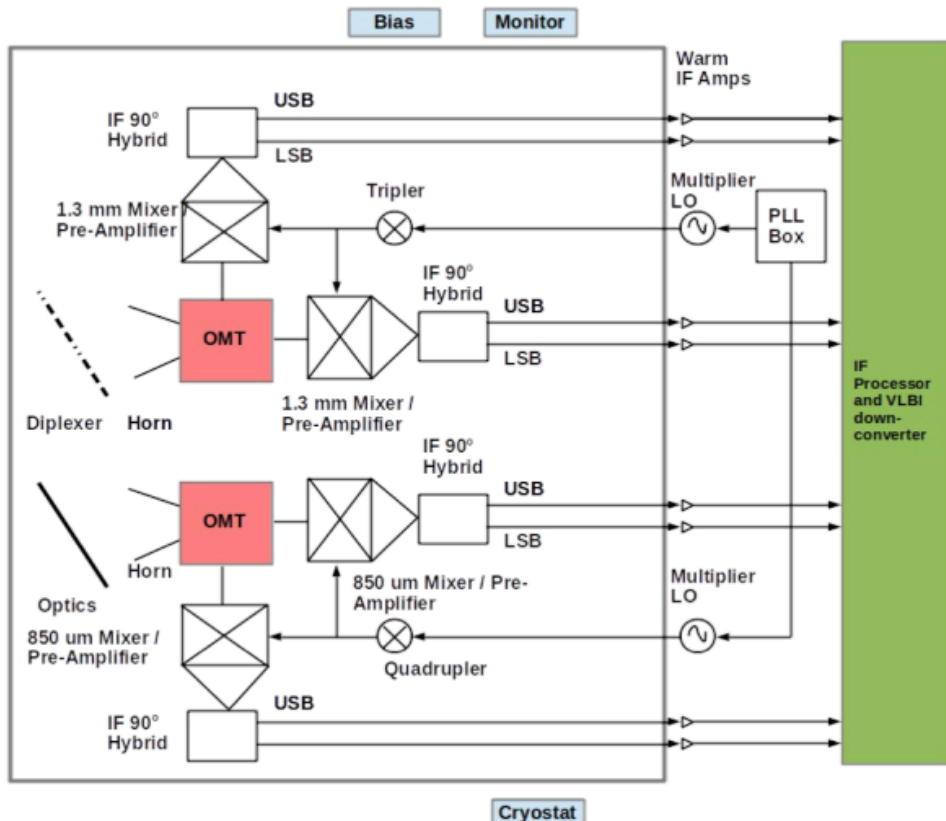
Figure 2. Block diagram for the dual-frequency